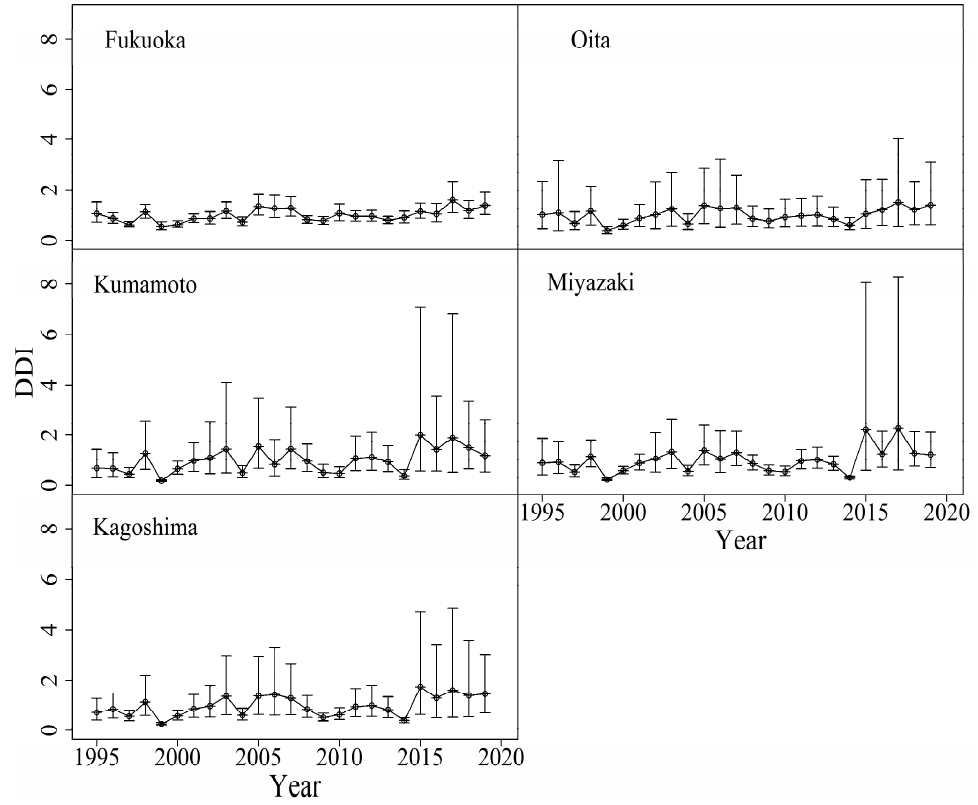
Figure 4. Deer density index (DDI) fluctuation in each prefecture. DDIs and error bars (95% CI) were estimated from the VAST model described in the text.